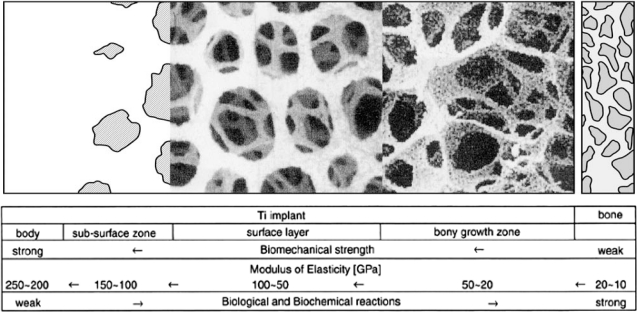
Schematic and conceptual Ti implant with gradient mechanical and biological functions.